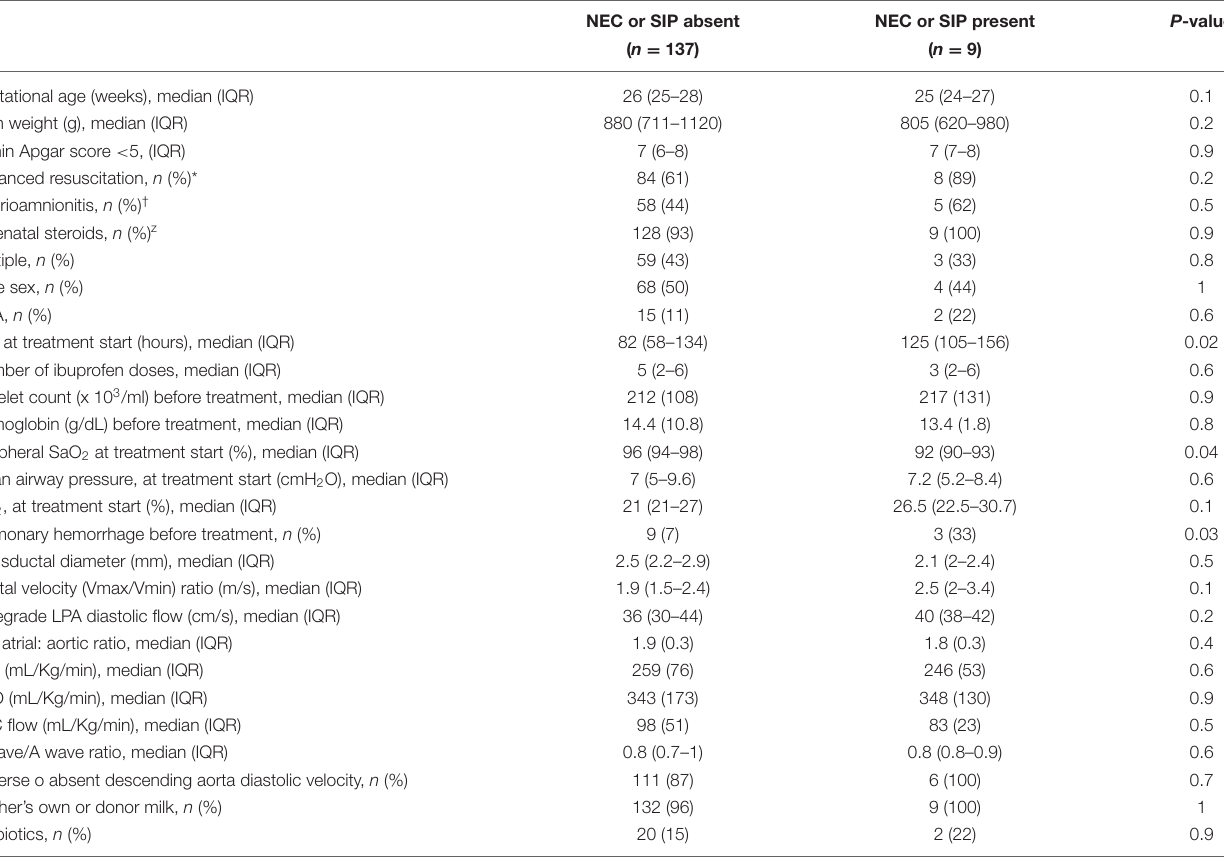
TABLE 4 | Associations between adverse bowel outcomes and perinatal, clinical or echocardiographic features in the study